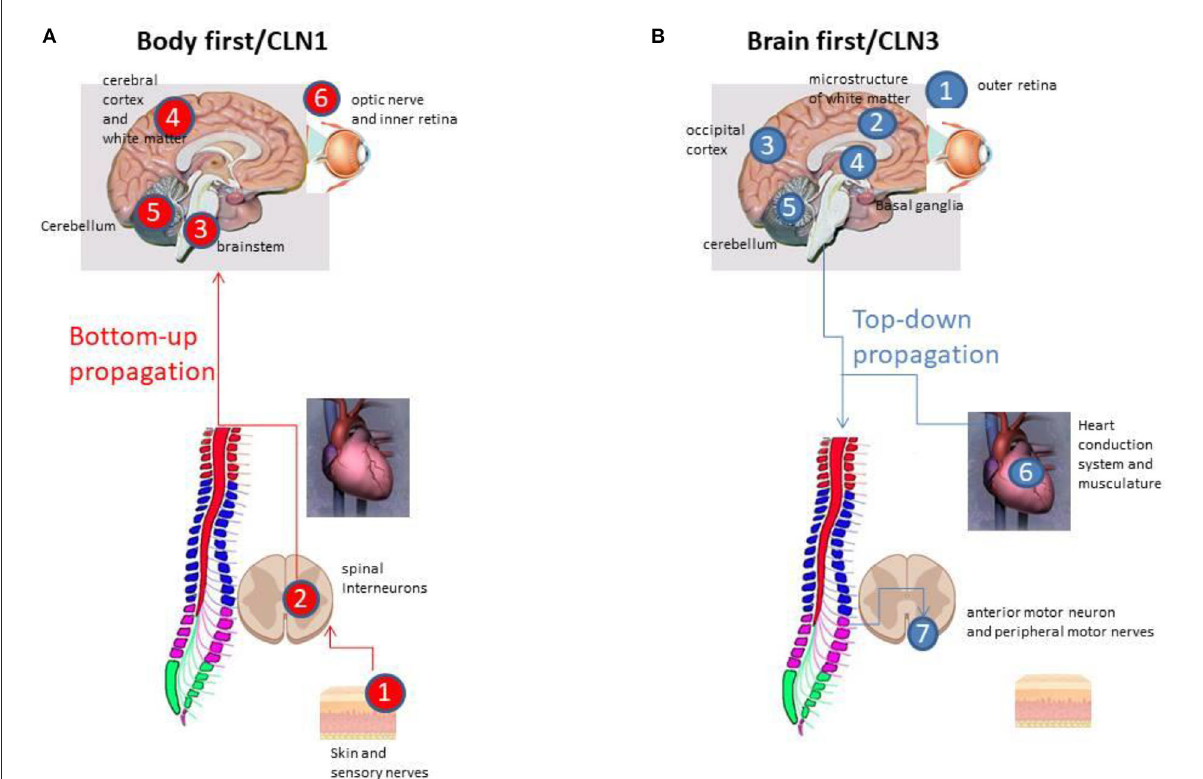
FIGURE1 (A) The “Bottom-up” propagation in CLN1 disease via the peripheral sensory nerves, the dorsal root ganglia and via the spinal interneurons to the brainstem (all within the initial 1–1 ½ years of life), and then into brainstem, the cerebral hemispheres, and, at 2 ½ − 3 years of age, affecting the cerebellum and retina. (B) The “Top-down” disease propagation in CLN3 starting at the outer retina 5–7 years of age, followed by cerebral and cerebellar atrophy in early and late adolescence, respectively, with the extrapyramidal system affected in between. Affection of the autonomic nerve supply of the heart, the sinus node and the heart conduction system takes place in late adolescence, whereas impact of the peripheral motor nerves occurs in late adolescents/early